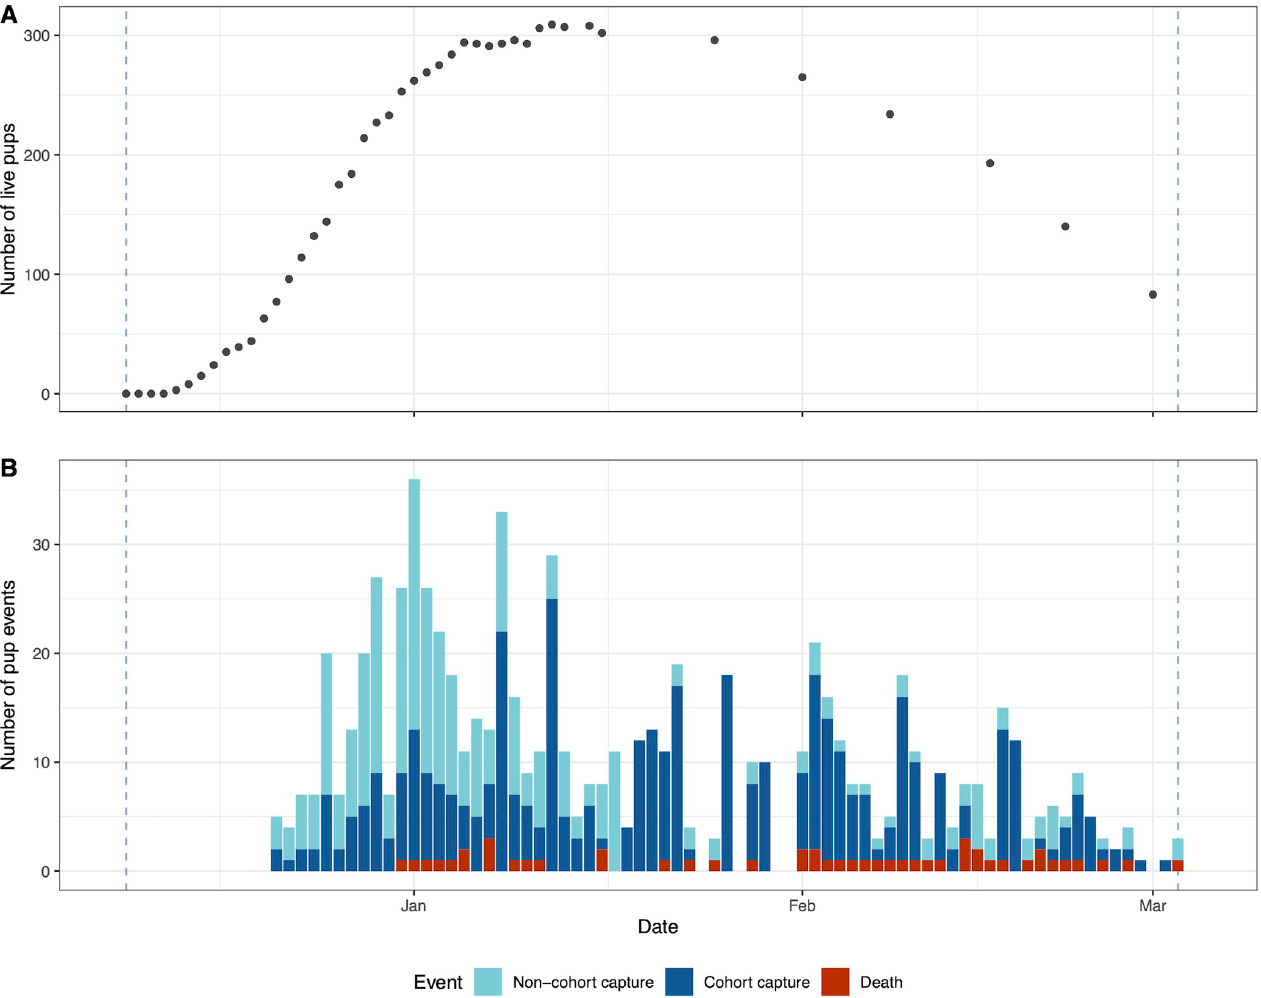
Fig 1. Summary of New Zealand sea lion pup census and events at Sandy Bay, Enderby Island during the 2017–18 season. Vertical dashed lines indicate the beginning and end of the monitored period. (A) Estimated cumulative pup count during daily colony monitoring until mid-January and then weekly census counts ongoing. Decreasing numbers of pups from mid-January are predominantly due to dispersal away from monitored areas. (B) Number of pup captures and deaths per day. Non-cohort captures include first and case-control captures.